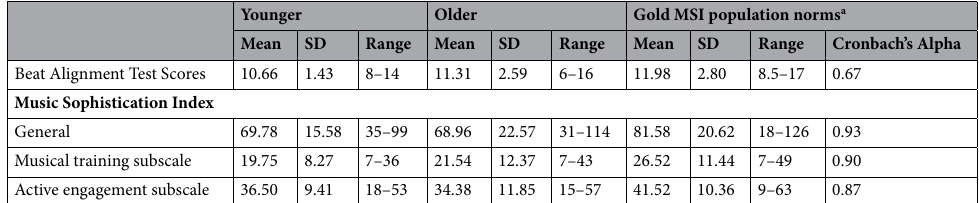
Table 3. Mean score of the goldsmiths beat alignment test and musical sophistication index by experimental group compared to population norms. a Data provided via personal communication from paper in submitted for publication 49